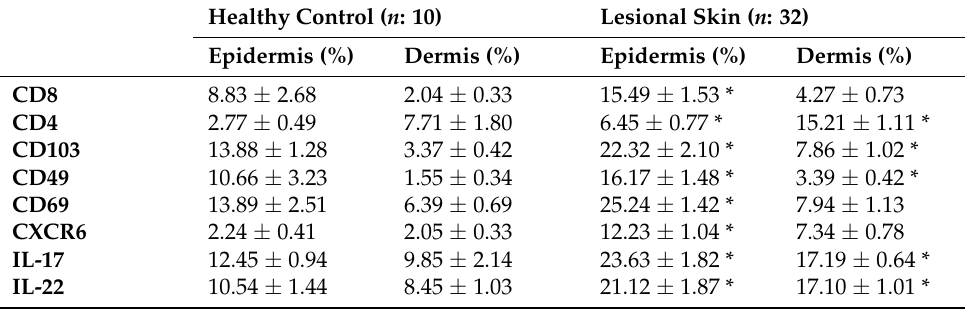
Table 1. Immunoreactive area (%) TRM markers (X ± SEM) in lesional skin ( n = 30, dermis and epidermis) in comparison with healthy control ( n = 10, dermis and epidermis). Asterisks show the statistically significant differences between analyzed